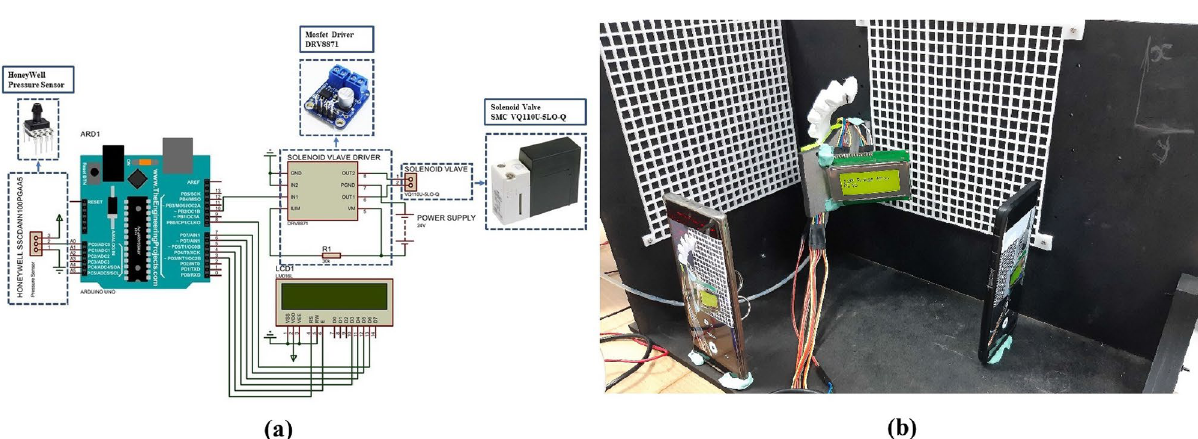
Figure 4. Experiment setup of testing SPA motion. ( a ) The pneumatic circuit used to control the applied pressure on SPA which changes with the PWM. ( b ) The SPA two frames captured with video for vision feedback to extract the coordinates of the SPA tip from each plane to be compared with FEA